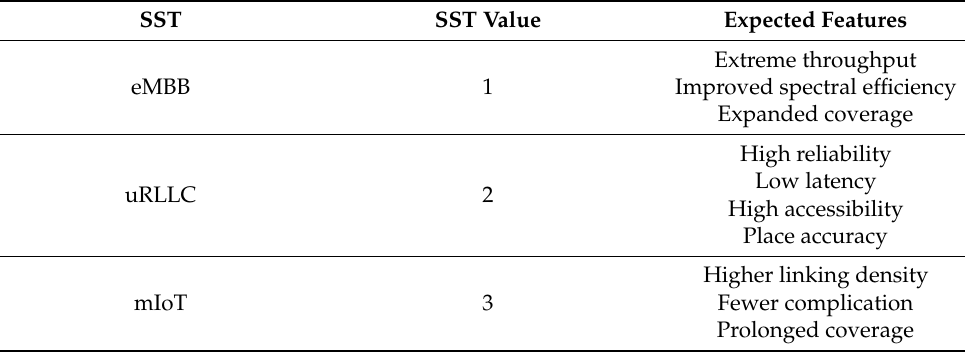
Table 1. Standardized SST values and their